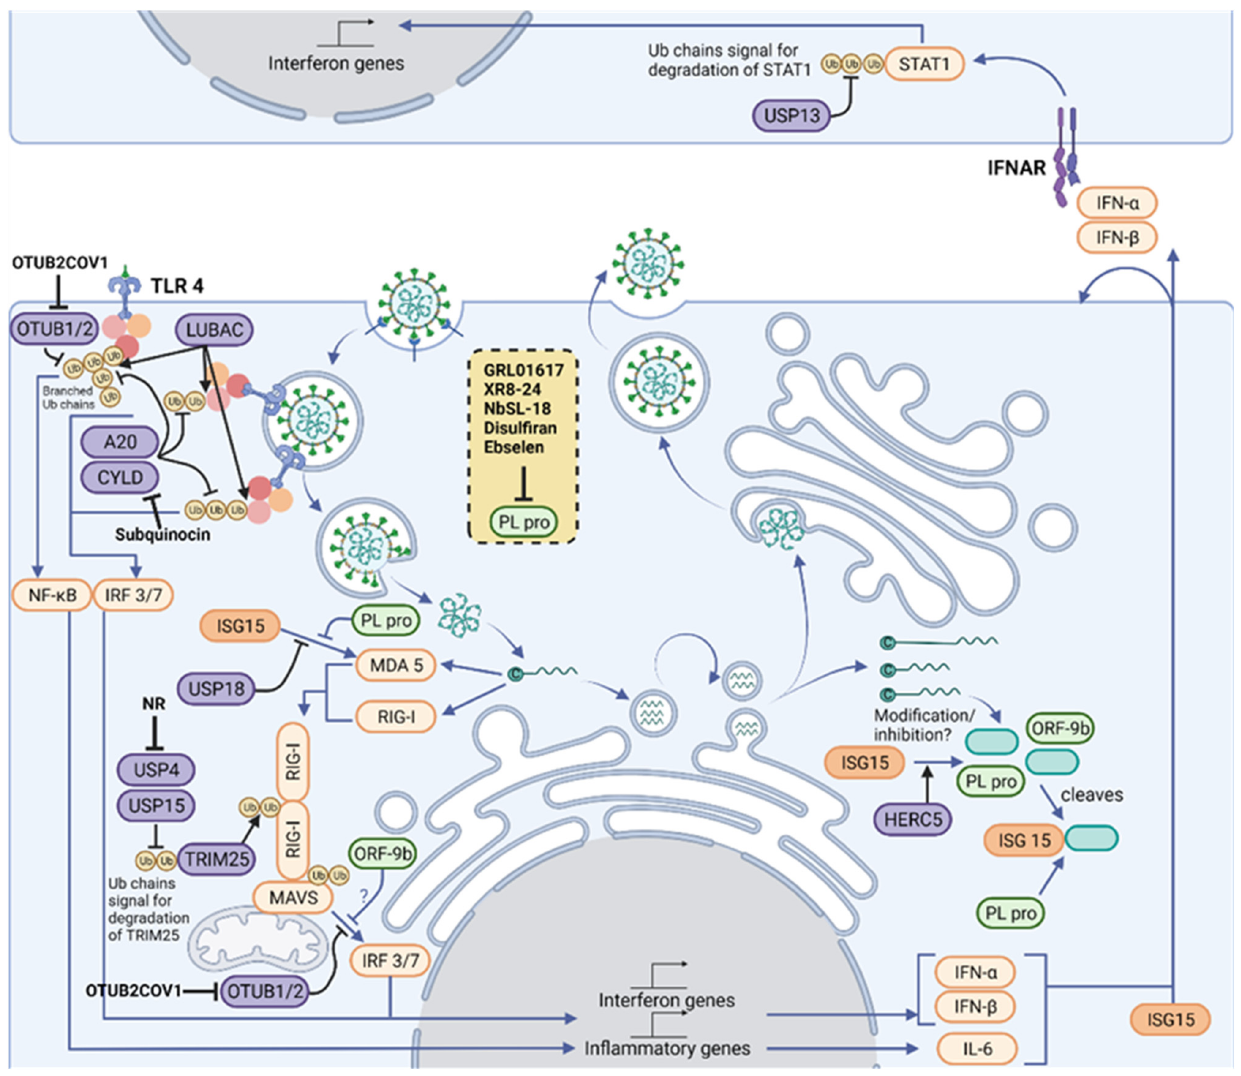
Figure 2. Therapeutic intervention points in the Ubiquitylation and ISGylation machinery of the host and of SARS-CoV-2 . Polyubiquitin chains are vital mediators in signaling downstream of three of the main families of innate immune signaling pathways, TLRs, RLRs and NLRs, which act together to sense a variety of PAMPs, including SARS-CoV-2. A network of E3 ligases and DUBs (purple) generate new ubiquitin (yellow) and ISG15 (orange) architectures during viral infection. For instance, LUBAC assembles linear ubiquitin chains on pre-existing K63-linked ubiquitin chains, forming branched structures. Their structures are reshaped and limited by OTUB1/2, OTULIN (not shown), A20 and CYLD. K63-linked ubiquitin chains are assembled on RIG-I by TRIM25, which allow its polymerization and activation of MAVS. In addition, the amount of K48-linked ubiquitin chains regulates TRIM25 levels, and these chains are cleaved by USP4 and USP15. MAVS signaling to IRF3/7 depends on ubiquitylation of NEMO (not shown), but this can be removed by OTUB1/2. Some of these pathways end up activating the IFN-I pathway, driving production of ISGs, including more IFN and ISG15. ISG15 is conjugated by HERC5 to host proteins, which activates antiviral signaling, and to viral proteins, which is believed to inhibit viral processes. Signaling from MDA5 and RIG-I to MAVS depends on the ubiquitylation of MAVS and RIG-I, as well as on the ISGylation of MDA5. Activated MAVS drives IRF3/IRF7-dependent IFN-I gene production. However, the cell also produces USP18, an ISG protease that removes ISG15 from cellular proteins, fine-tuning IFN signals. An antiviral response is driven by neighboring cells through paracrine signaling of type I IFNs. The extent of downstream signaling depends on levels of STAT1, which is